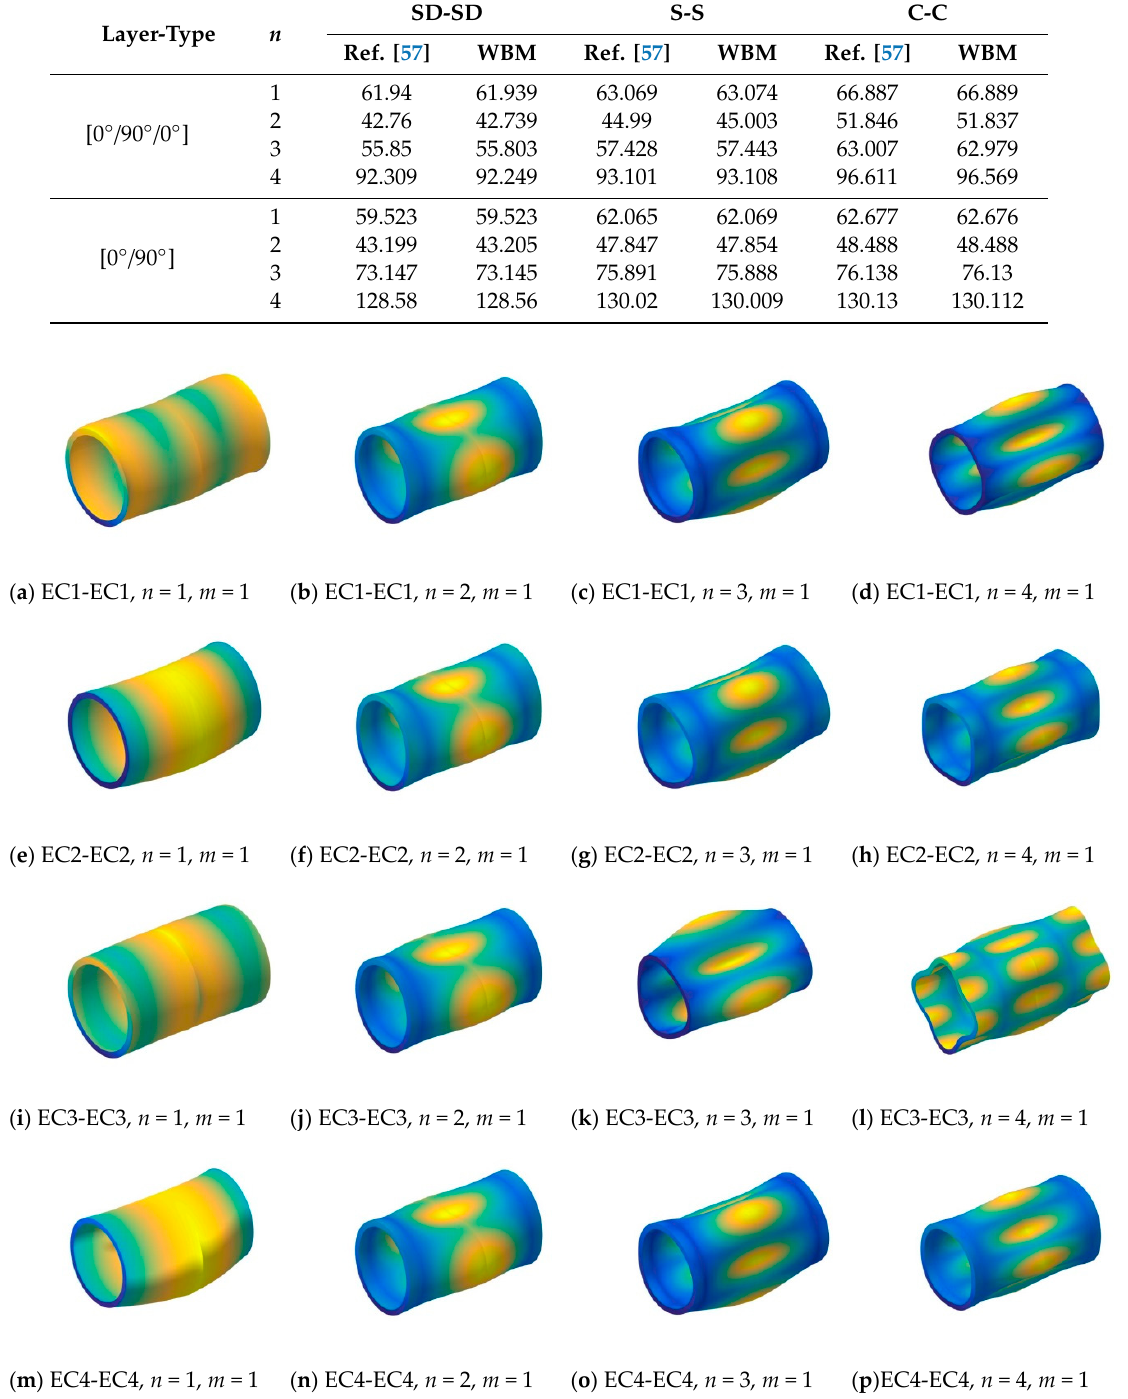
Figure 3. The modal shapes of a three-layered [0°/90°/0°] composite shell with various elastic boundary conditions.